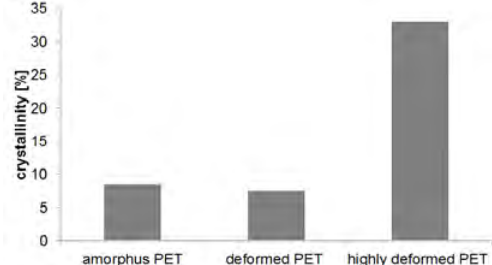
Figure 3. Crystallinity of PET samples, measured via DSC; (A) amorphous, (B) deformed and (C) highly deformed PET.